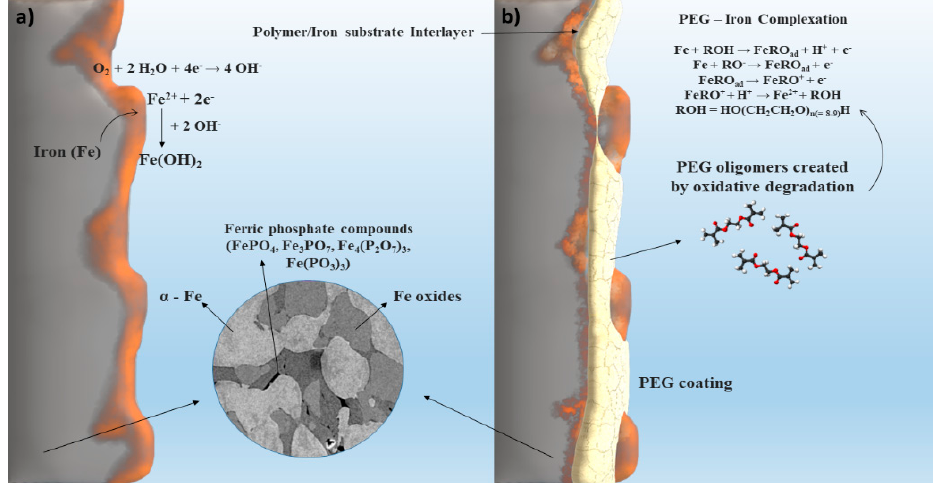
Figure 6. Schematic illustration of differences in passive layer density and corrosion behavior of iron-based foams in Hanks’ solution: Fe, Fe / P ( a ), Fe-PEG, Fe / P-PEG ( b ). EIS measurements were also performed after immersion of foams for 1 h in Hanks’